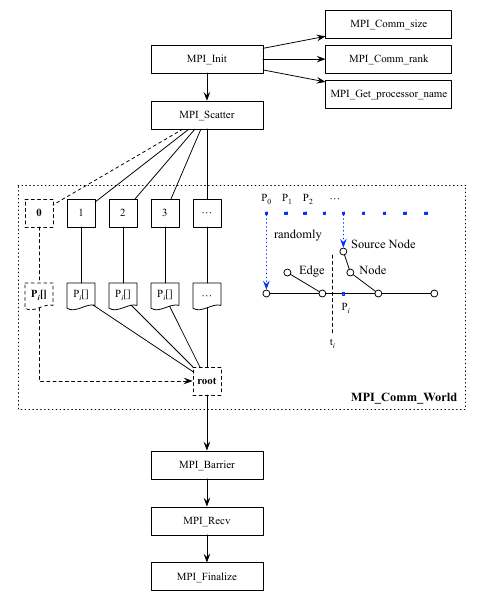
Figure 2: The flow path network and the particle system.